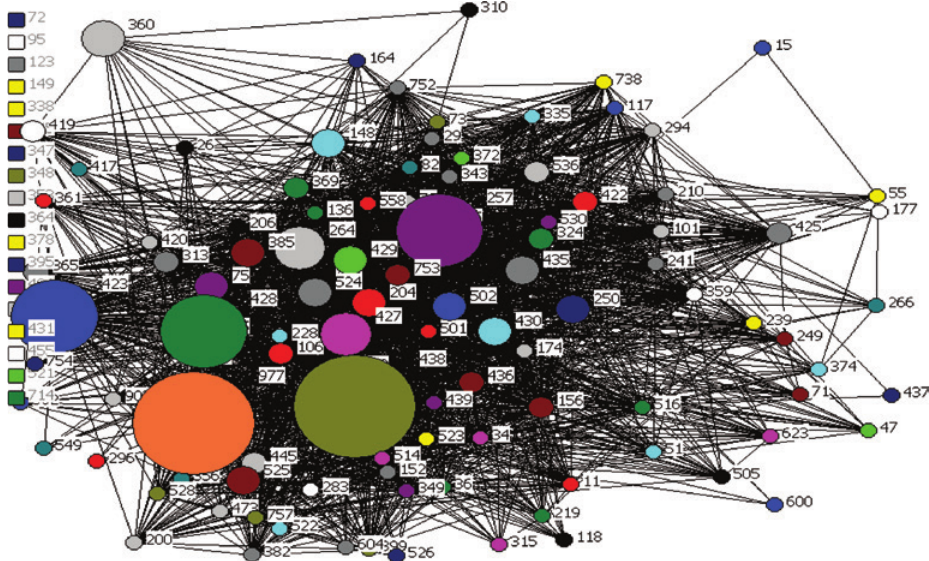
Figure 3: The classification number network in 2001 ~